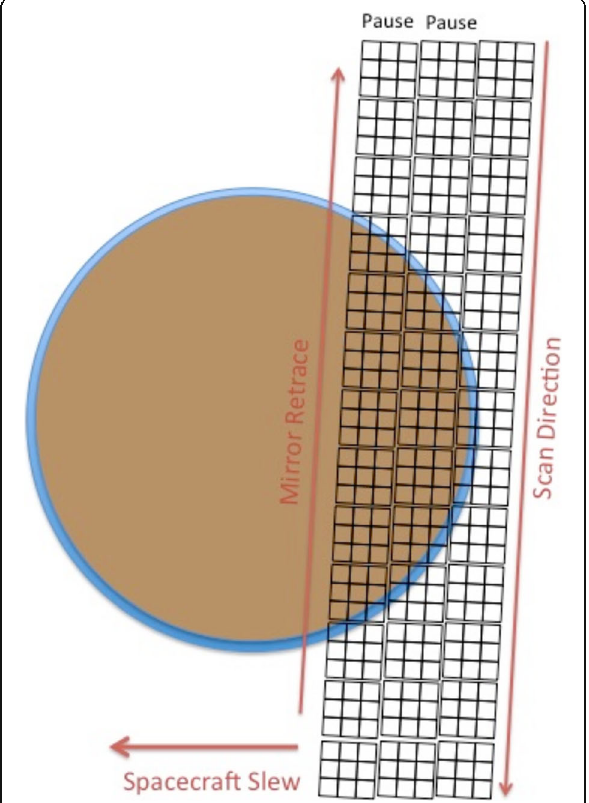
Fig. 3 Observation strategy of the EMIRS instrument, which has a 3×3 element footprint (corresponding to its 3×3 array detector). During one observation cycle, a scan of the Martian disk with minimal gaps is performed. The line-of-sight pointing of the instrument is controlled by spacecraft slew and rotation, retracing, and pausing of the scan mirror. Source: Altunaiji et al.